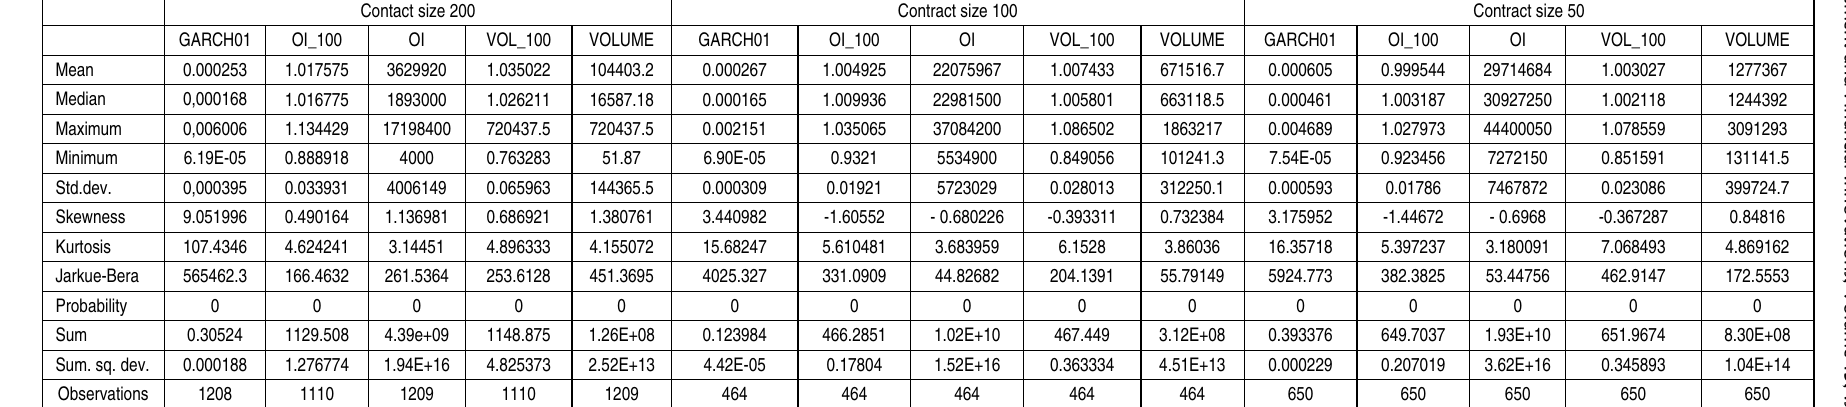
Table 1. Descriptive statistics of adjusted trading volume (VOL_100), actual volume in lakhs (VOLUME), adjusted open interest (OI_100), actual open interest (OI) and unconditional volatility (GARCH01) of different contract size of 200,100 and 50 units for three sub periods from 06/12/2000 to 03/31/2005, 04/01/2005 to 02/06/2007 and 02/07/2007 to 04/24/2009,